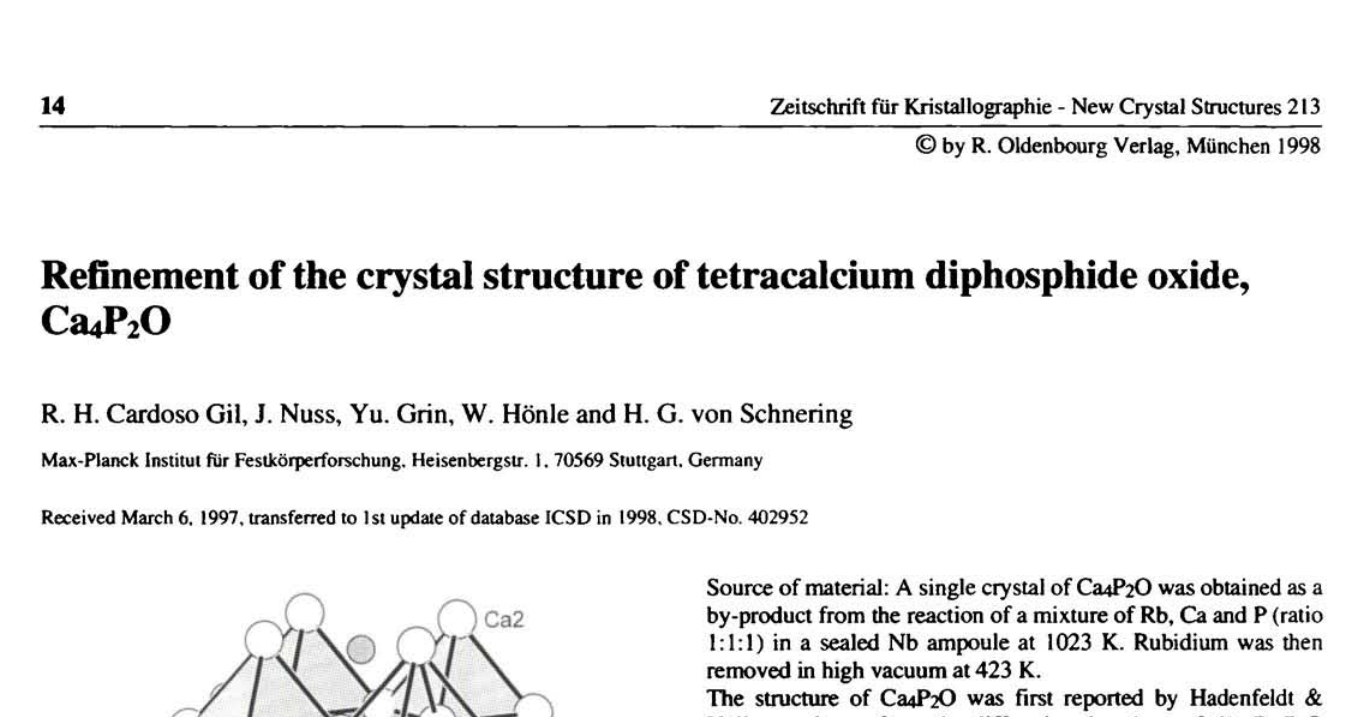
Table 1. Parameters used for the X-ray data collection Crystal: